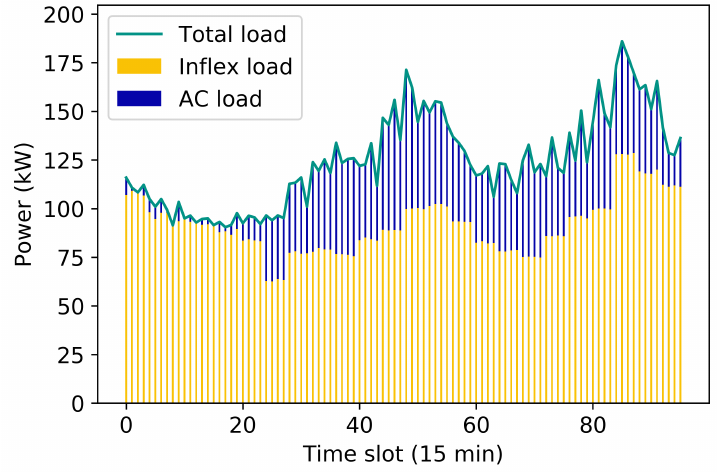
Figure 5. Total energy consumption of the community with ACs in the base scenario (without energy management).